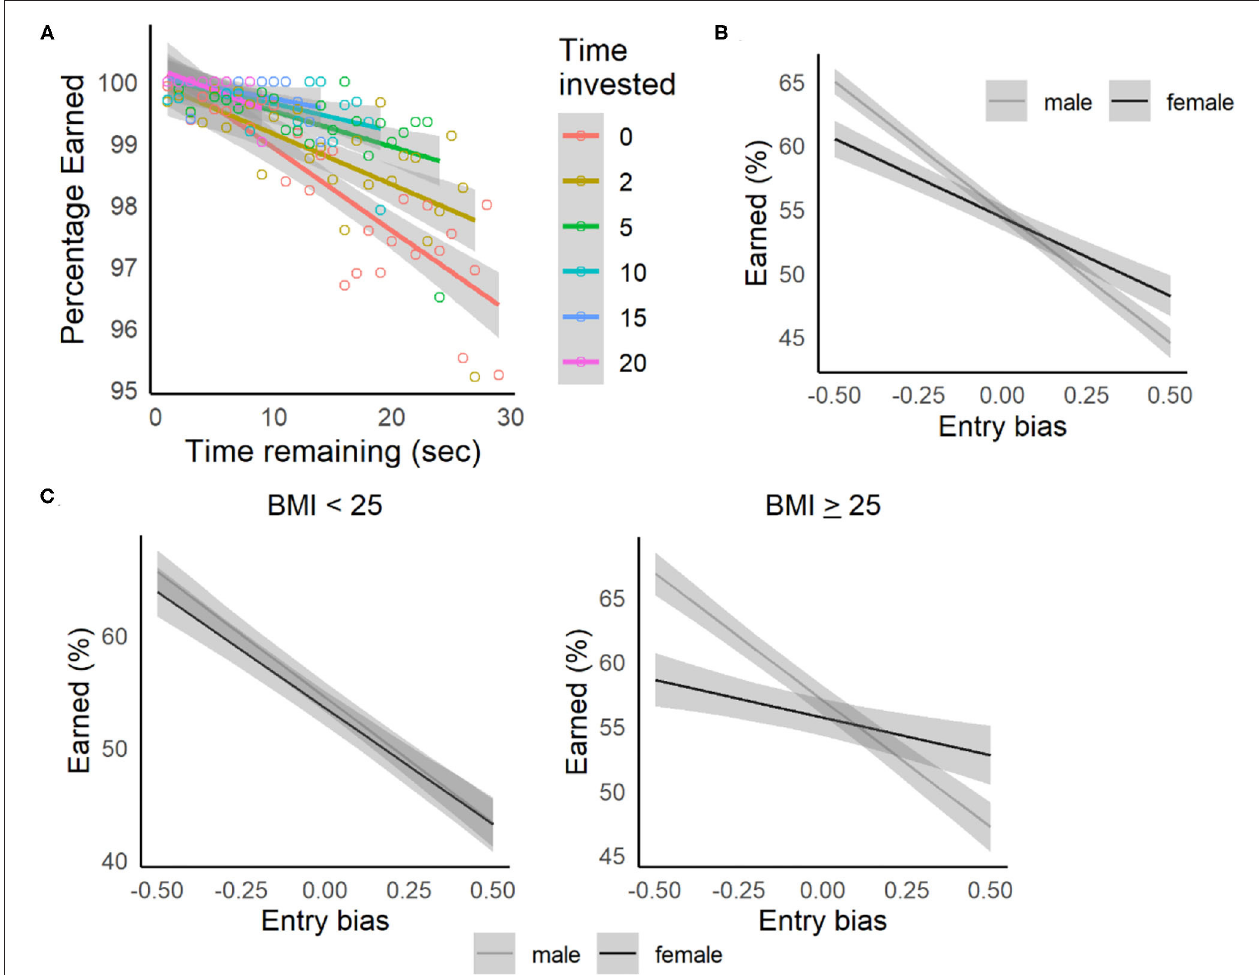
FIGURE 6 | Sunk-cost relationships. (A) Replication of sunk-cost results from the Restaurant Row and Web-Surf tasks. Quit rates (leaving before the delay was completed) increased as a function of delay (time invested = 0 seconds). The probability of staying for the remainder of the delay increased as a function of amount of time invested (investments of 2–20s shown). Shaded areas indicate the 95% confidence intervals, color-coded by the amount of time invested. (B) Percentage of rewards earned by gender, estimated as a function of entry bias (relative to the center of the pathway). Participants were more likely to accept rewards when entering to the left of center, and more likely to skip them when entering to the right of center, with females showing a weaker sensitivity to this bias, especially for those with BMI ≥ 25 (C) . Lines and shaded area represent estimated means and 95% confidence intervals based on the regression model.